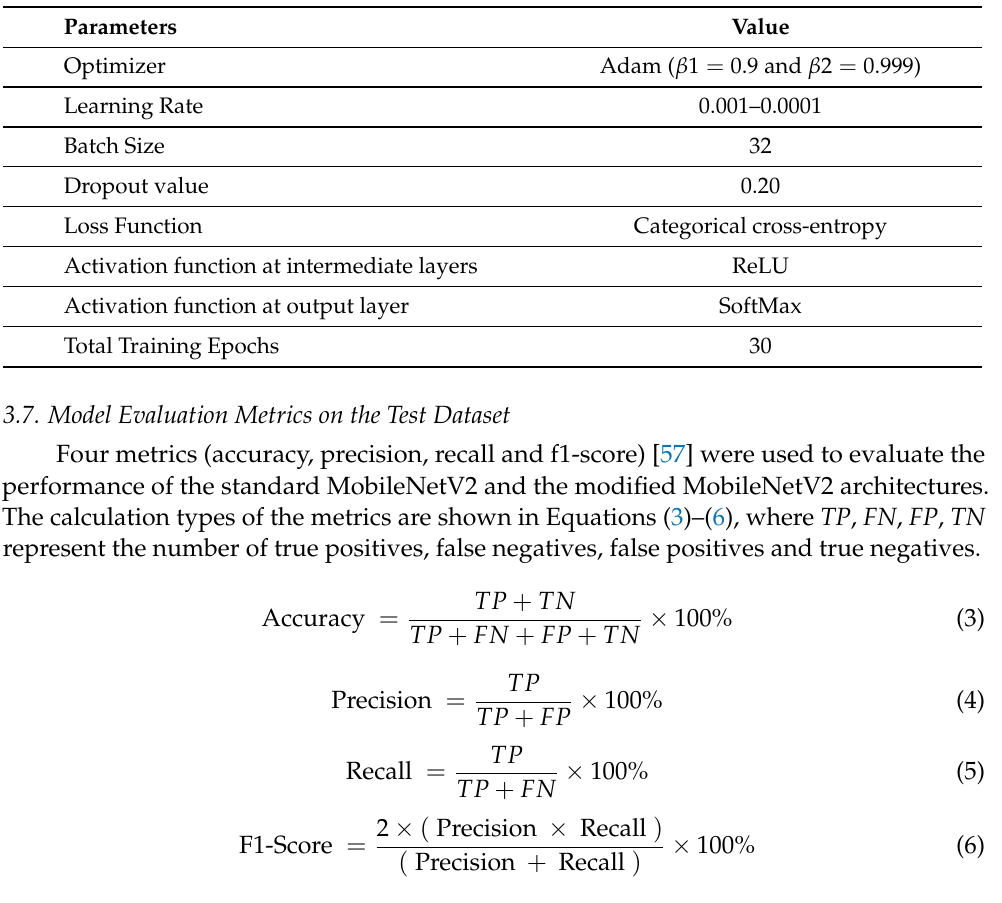
Table 3. The hyperparameters were used for all the experiments on the Jetson AGX Xavier embed- ded